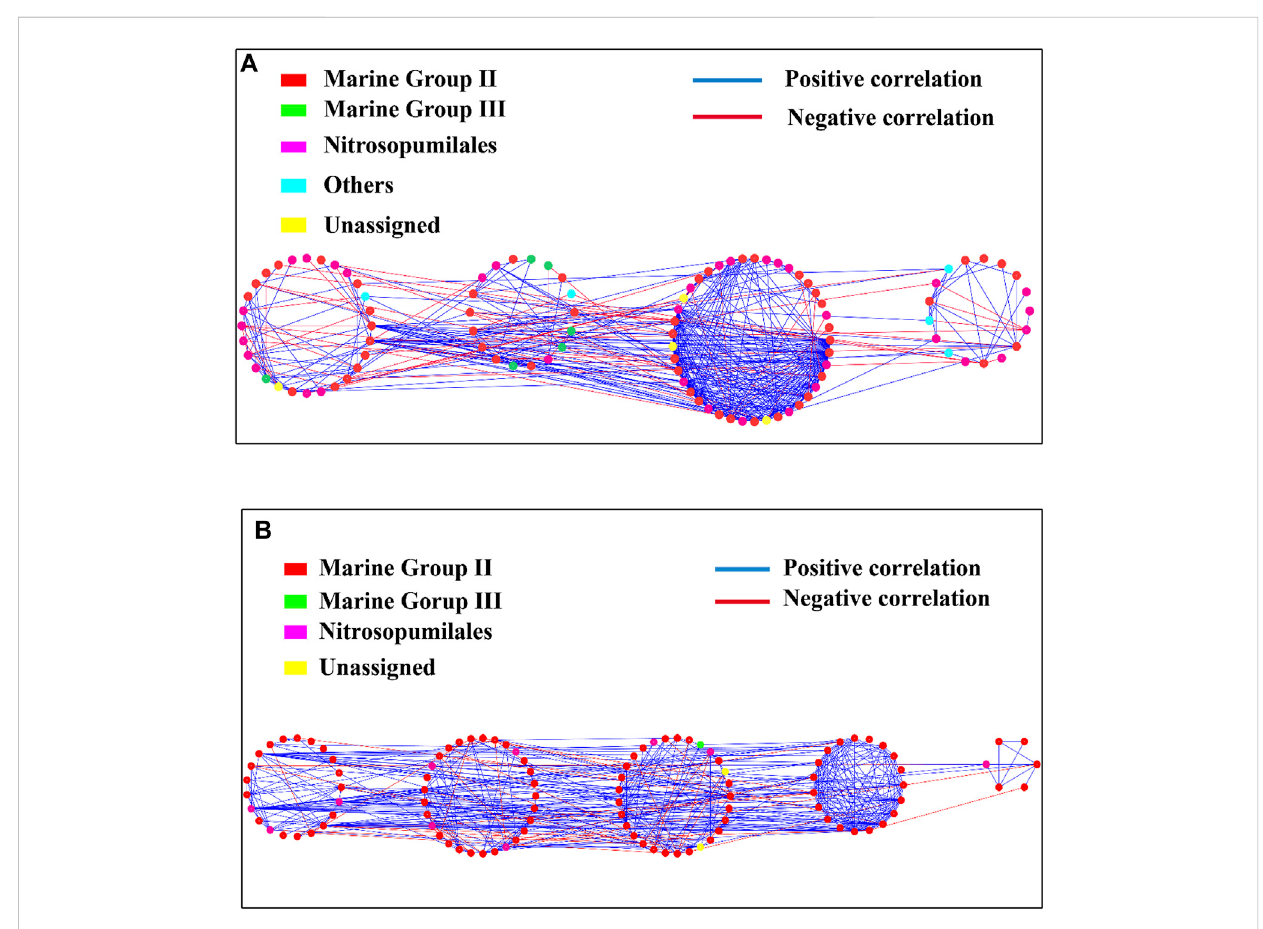
FIGURE 9 Network of archaeal communities in the hypoxic (A) and non-hypoxic zones (B)